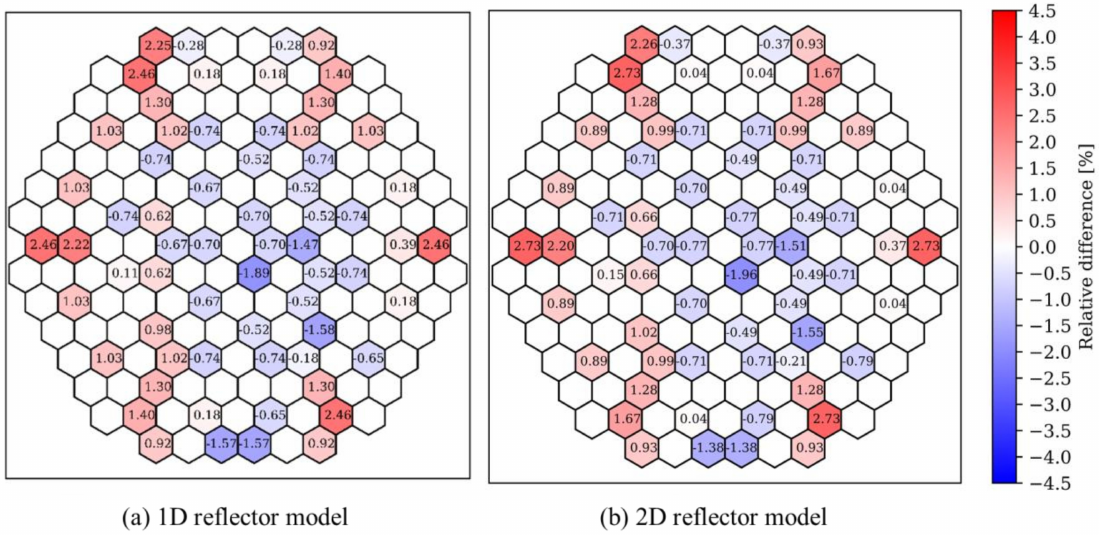
Figure 23. Relative radial power difference of RAST-K compared with measurement.